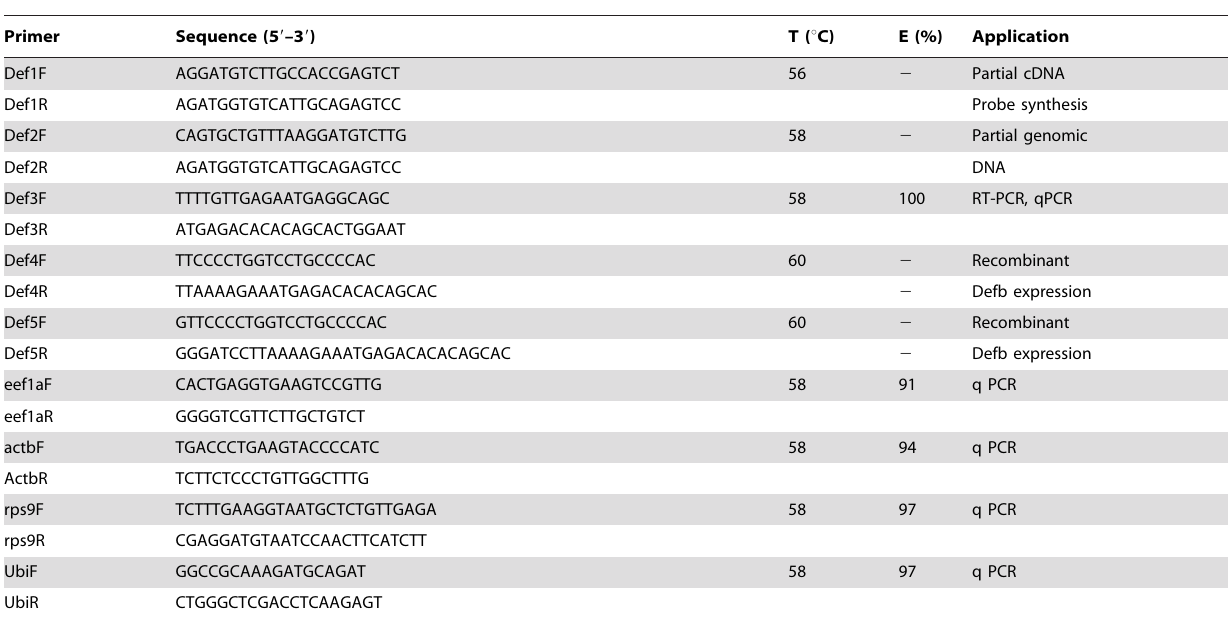
Table 1. List of primers employed and their application in this study.